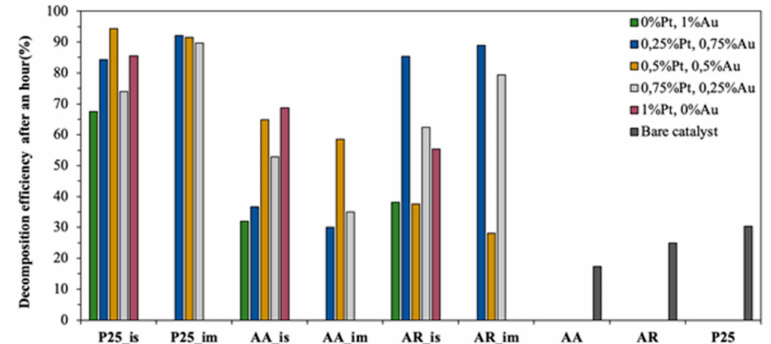
Figure 7. Decomposition efficiency for the degradation of oxalic acid after an hour.